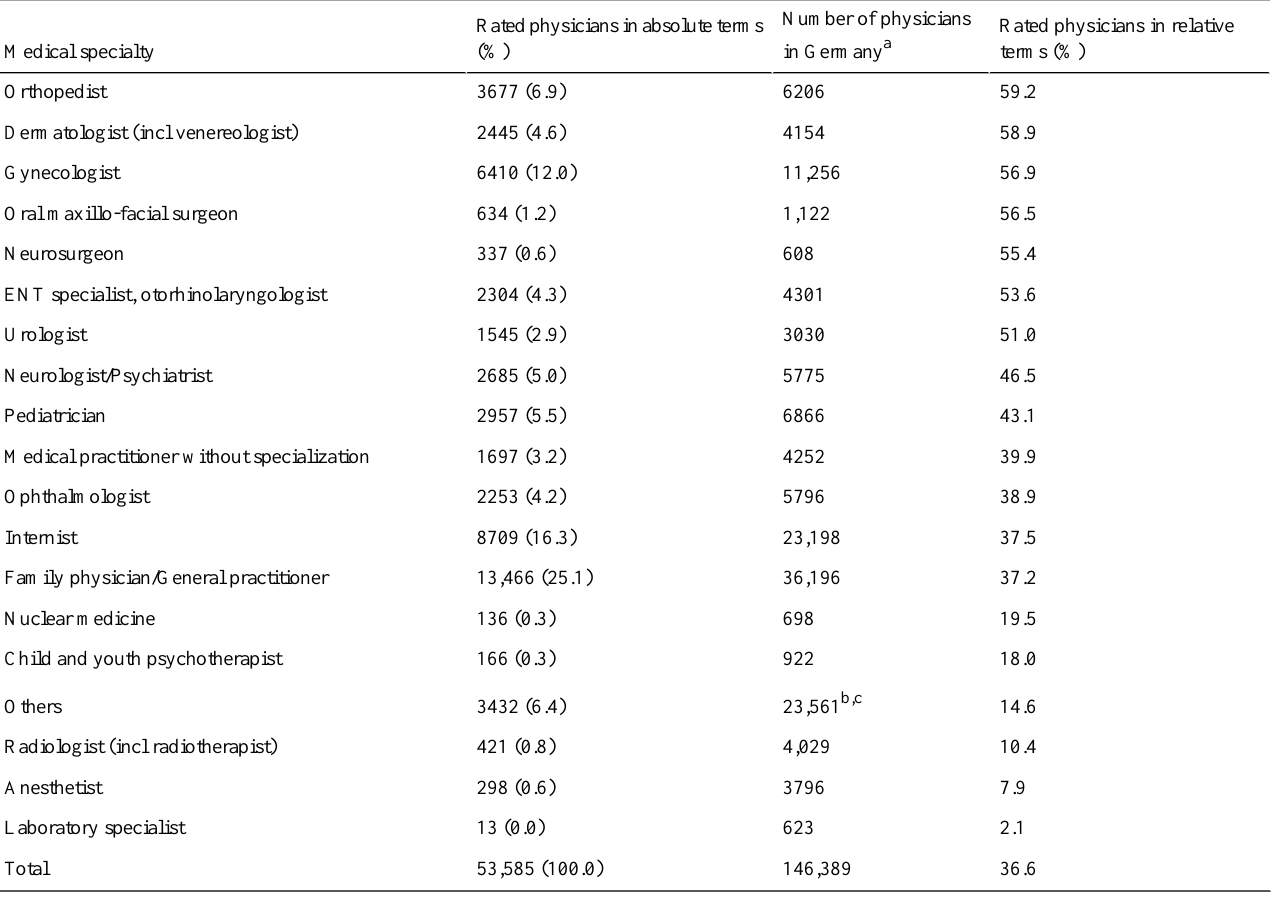
Table 3. Number and distribution of ratings according to medical